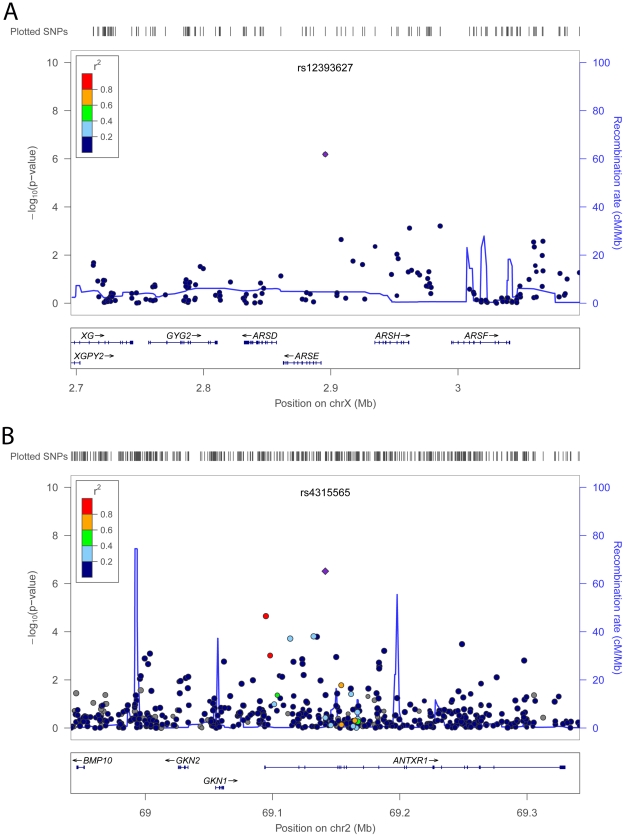
SNPs are plotted using LocusZoom [22] by position on the chromosome against association with adult height (−log10
P).The SNP name shown on the plot was the most significant SNP after the discovery meta-analysis. Estimated recombination rates (from HapMap) are plotted in cyan to reflect the local LD structure. The SNPs surrounding the most significant SNP are color coded to reflect their LD with this SNP (taken from pairwise r
2 values from the ARIC African Americans Affymetrix6.0 dataset for rs1239627 (A) and from the HapMap YRI data for rs4315565 (B)). The size of the points on the plots is proportional to the number of individuals with available genotype for any given SNP. Genes, the position of exons and the direction of transcription from the UCSC genome browser are noted. Hashmarks represent SNP positions available in the meta-analysis.